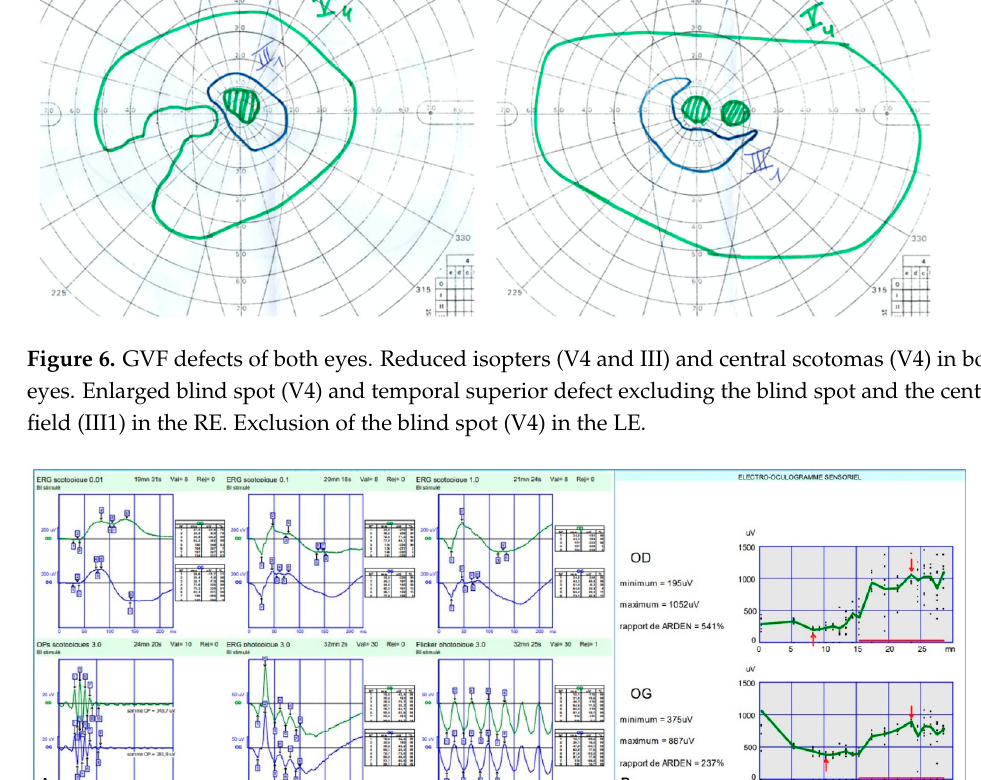
Figure 5. Swept source OCT and OCT-Angiography of macular telangiectasia in both eyes. ( A )—En face OCT-A (3 × 3 mm): Perifoveal tortuous capillaries and vascular voids in the SCP (red circle). Perifoveal markedly dilated telangiectatic and rarified capillaries in the DCP (yellow arrows). Dis- torted FAZ in both SCP and DCP. Vascular anomalies are mainly temporal in the RE and more circumferential in the LE. ( B )—Structural B-Scan OCT: Hyporeflective cystic cavities within inner foveal layers (orange arrowheads), around areas of vascular anomalies. Goldmann visual field (GVF) revealed reduced isopters associated with central sco- tomas in both eyes. We noted an enlarged blind spot associated with a temporal superior defect with exclusion of the blind spot and the central field in the RE and an exclusion of the blind spot in the LE (Figure 6).